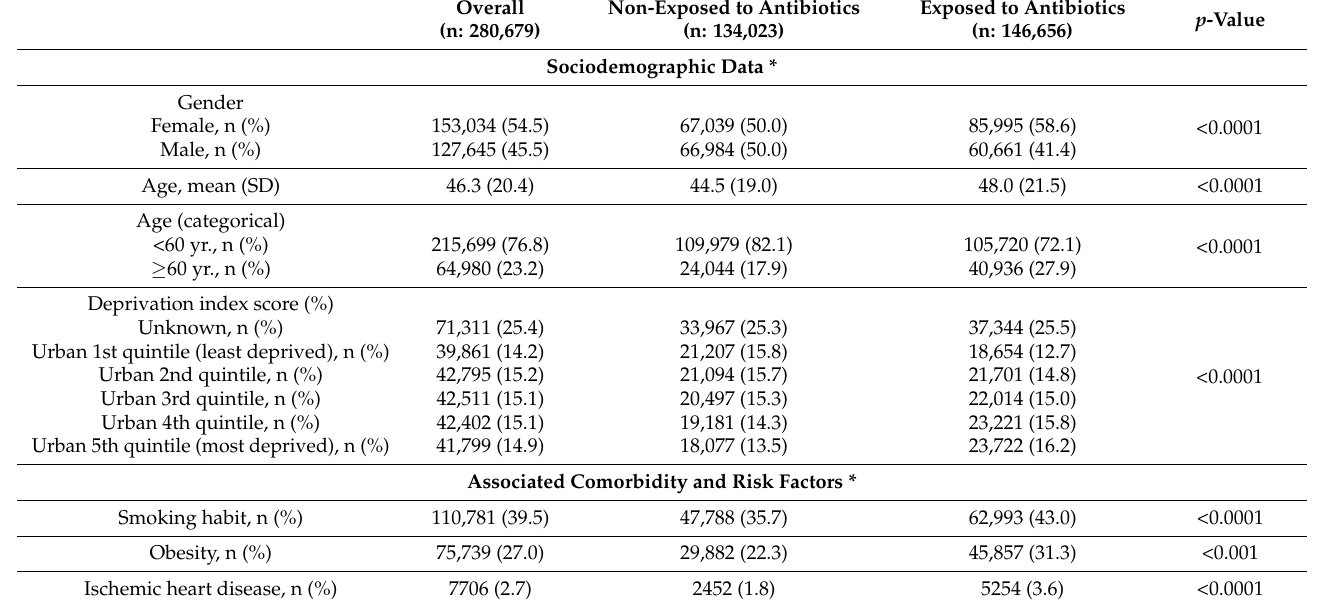
Overall Non-Exposed to Antibiotics Exposed to Antibiotics (n: 280,679) (n: 134,023) (n: